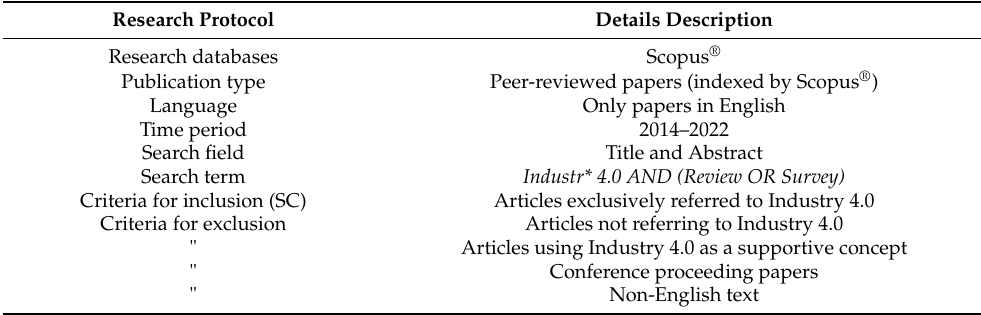
Table 1. Summary of the literature search protocol including inclusion and exclusion